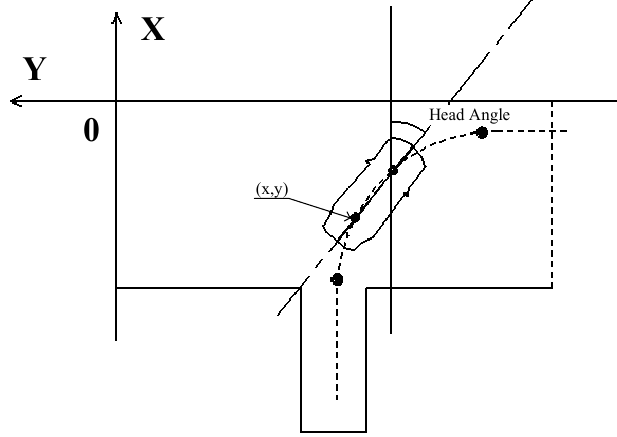
Figure 9. The head angle of the vehicle in the reverse parking location.